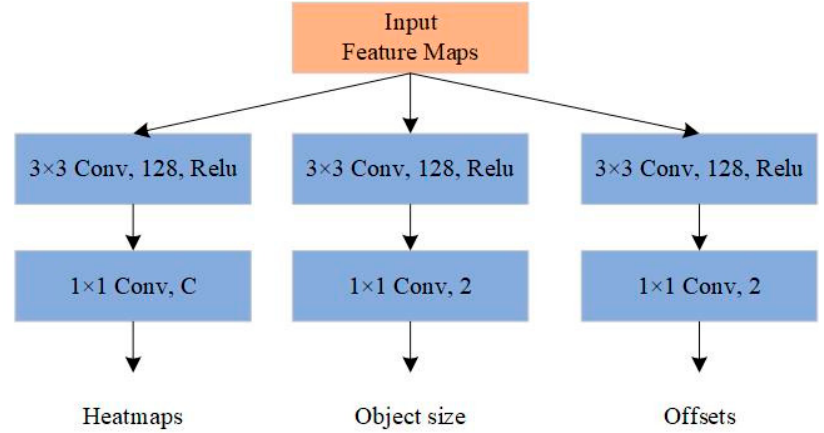
Figure 8. The structure of the prediction module. C is the number of key point types. Using the predictions, we can locate the center point and estimate the size of objects.